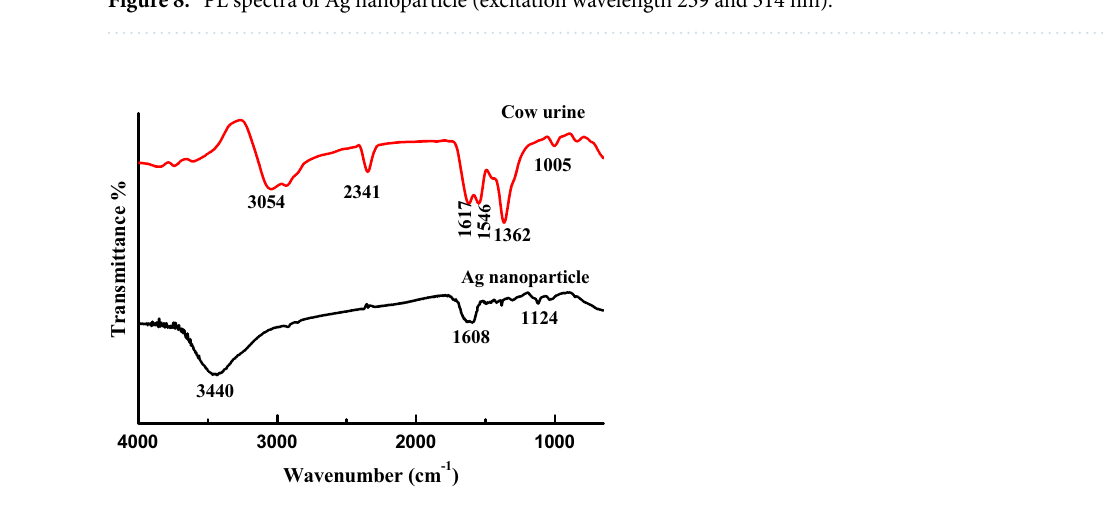
Figure 8. PL spectra of Ag nanoparticle (excitation wavelength 239 and 314 nm).